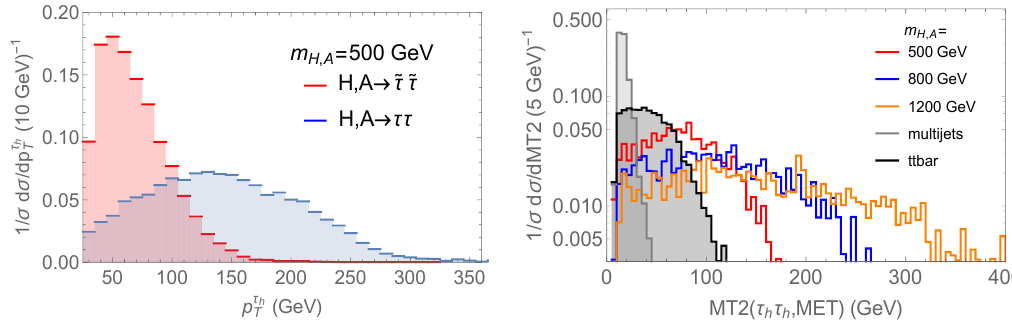
Figure 9 . Left panel : the di(cid:11)erential p T distribution of the hadronic (cid:28) jets produced directly from H; A ! (cid:28)(cid:28) (blue) and from stau decays from H; A ! ~ (cid:28) ~ (cid:28) (red), in the b (cid:22) b associated production of the heavy Higgs bosons, with m H;A = 500 GeV, m ~ (cid:28) = 225 GeV, and m (cid:31) = 100 GeV. Right panel: 1 the di(cid:11)erential m T 2 distribution of the hadronic (cid:28) jets from H; A ! ~ (cid:28) ~ (cid:28) from b (cid:22) b associated pro- duction. We show the distribution for m H;A = 500 ; 800 ; 1200 GeV, m ~ (cid:28) = 225 ; 375 ; 575 GeV in red, blue, orange, respectively, with m (cid:31) = 100 GeV. The gray shaded regions show the corresponding 1 di(cid:11)erential distributions for the two leading backgrounds from SM multijet process (lighter gray) and t (cid:22) t (darker